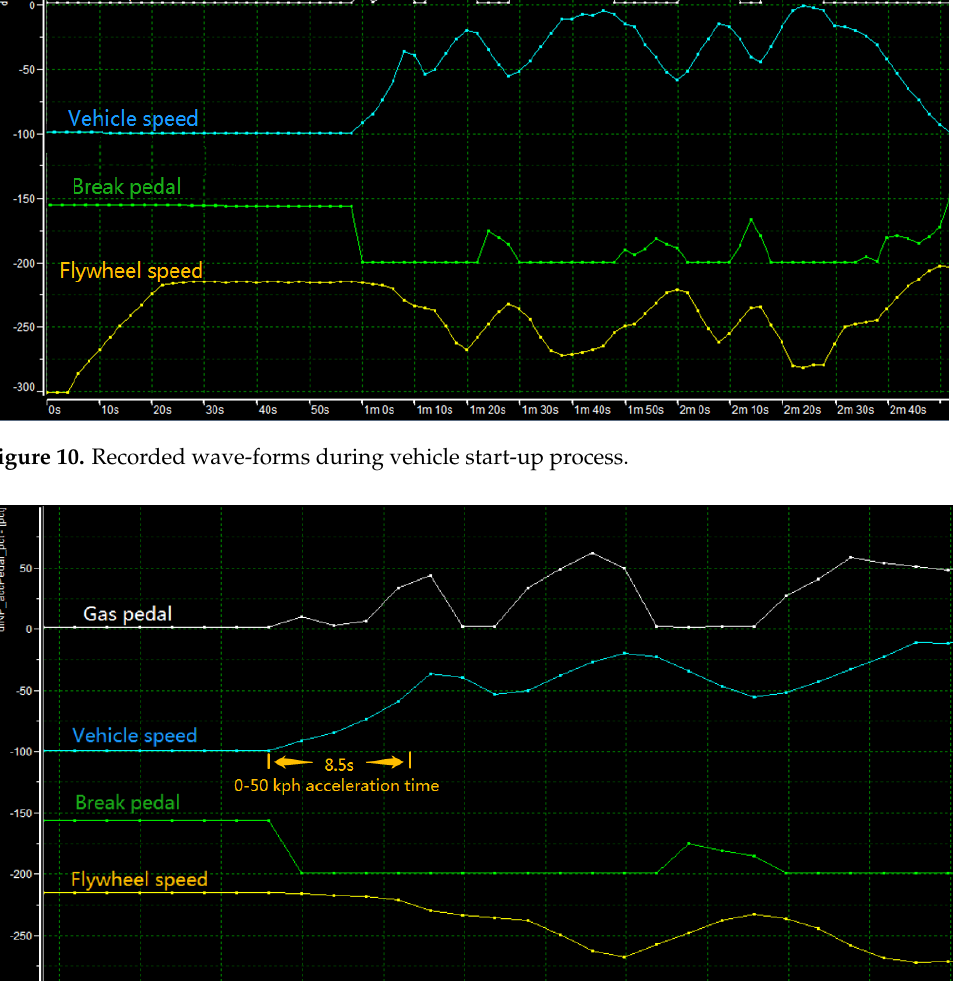
Figure 11. Expanded wave-forms during launch period.